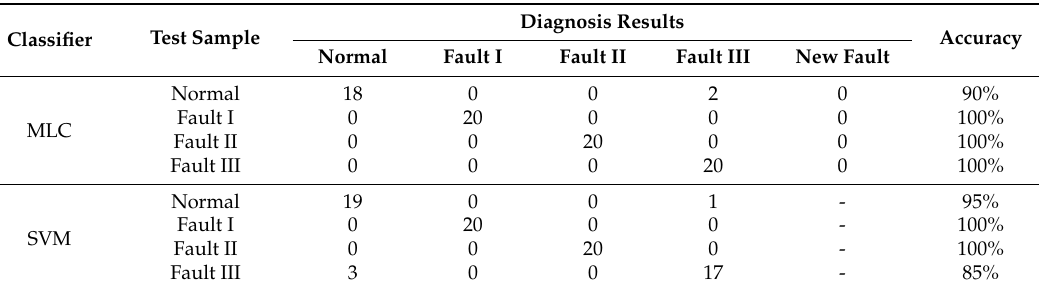
Table 2. Diagnosis results using MLC and SVM.